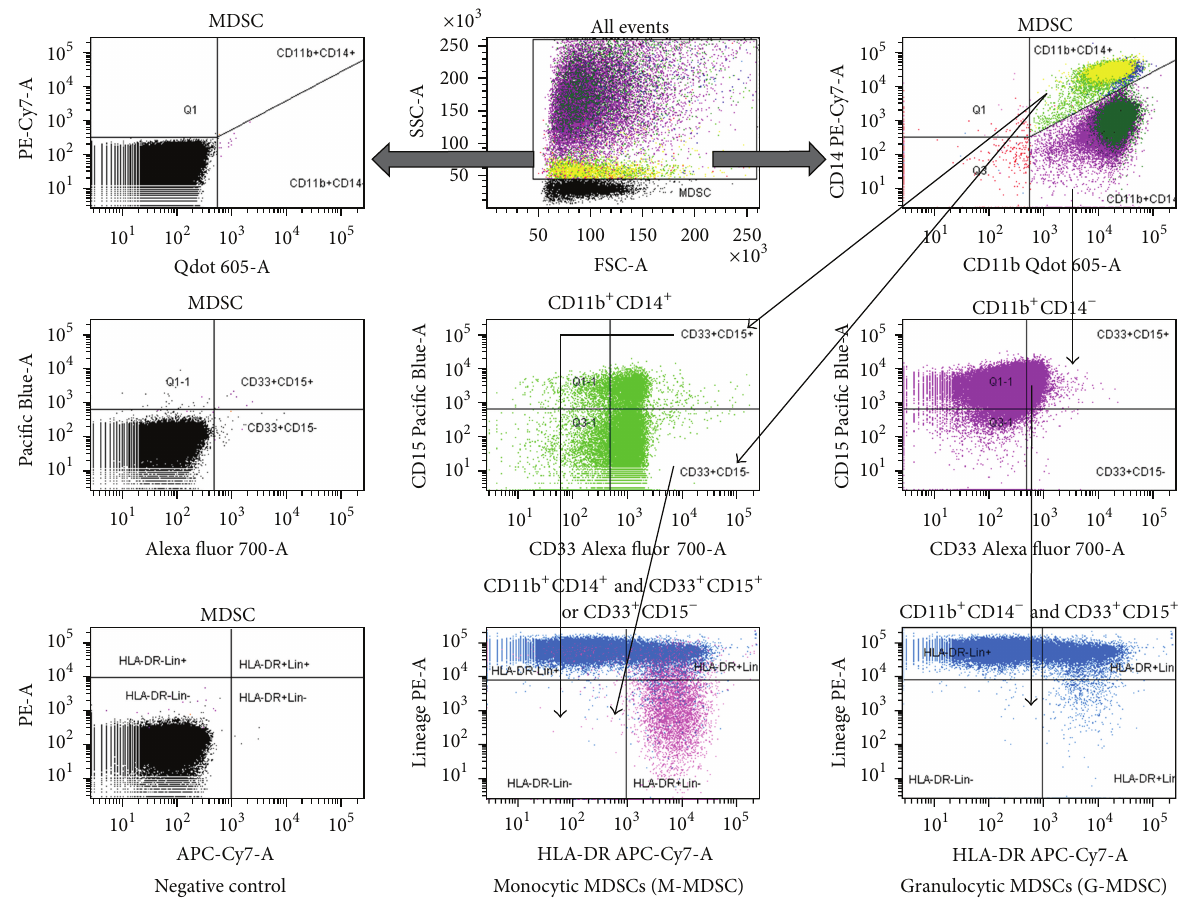
Figure 1: Phenotypic analysis of MDSC subpopulations in NSCLC patients. Representative dot plots, as well as the gating strategy for identification and quantification of MDSCs. Arrows indicate the sequence of gating. The gates for each dot plot and histogram are presented on the top of each box. The positive expression of markers compared to cells without Ab staining. Purple color represents the CD11b + CD14 − population whereas bright light green represents the CD11b + CD14 + population.